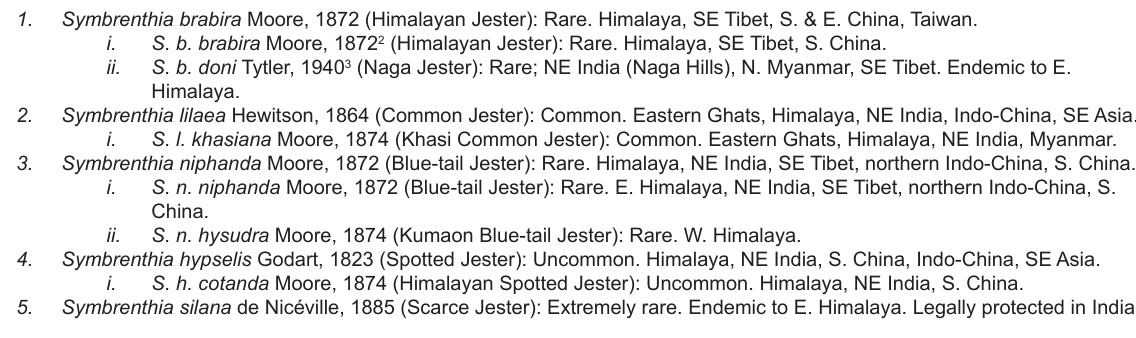
Symbrenthia brabira